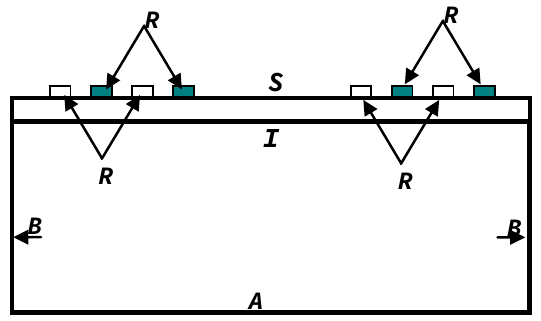
Figure 5. Boundary condition